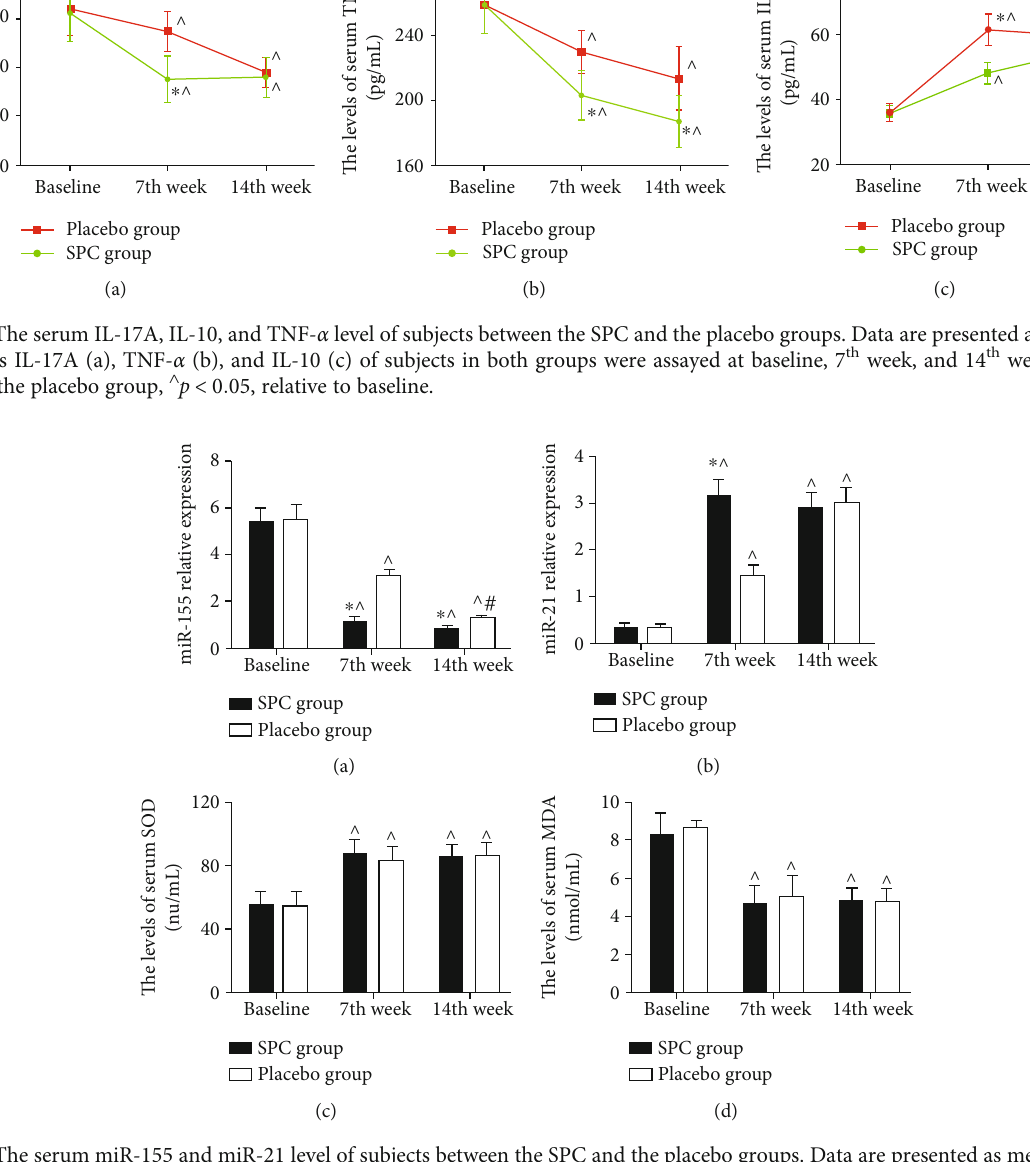
Figure 3: The serum miR-155 and miR-21 level of subjects between the SPC and the placebo groups. Data are presented as mean ± SD . The serums miR-155 (a), miR-21 (b), SOD (c), and MDA (d) of subjects in both groups were assayed at baseline, 50 th day, and 100 th day. ∗ p < 0 : 05 , relative to the placebo group, ∧ p < 0 : 05 , relative to baseline, and # p < 0 : 05 , relative to the 7 th week.